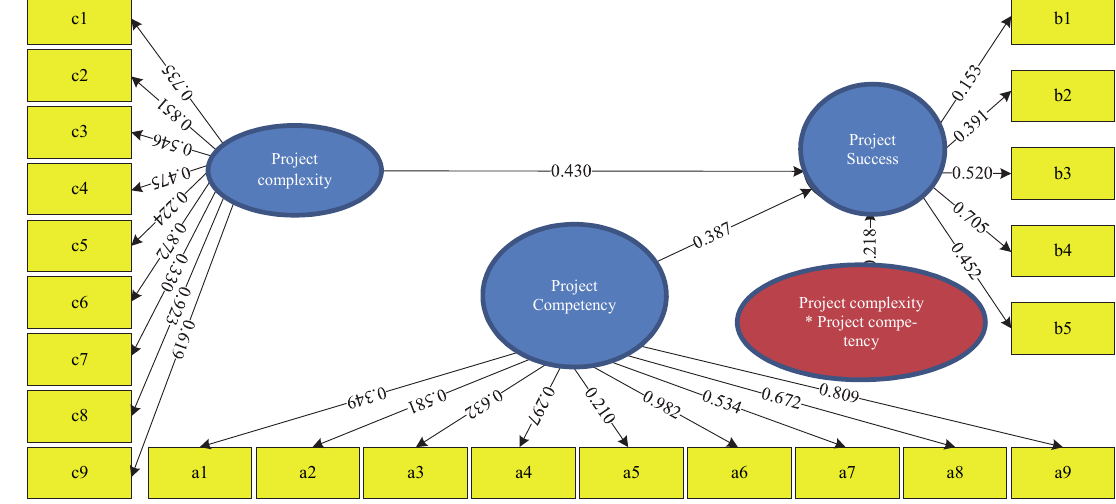
Fig. 4. Relationship between the complexity of the environment and the success of the project with the role of behavioral moderation, along with standardized